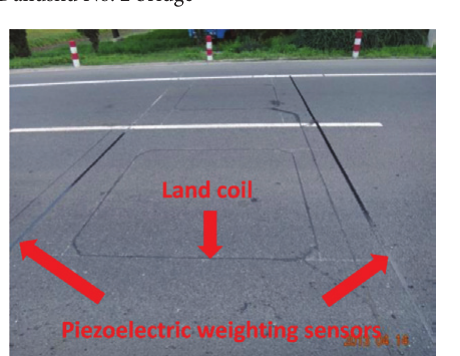
Fig. 1. Daliushu No. 2 bridge